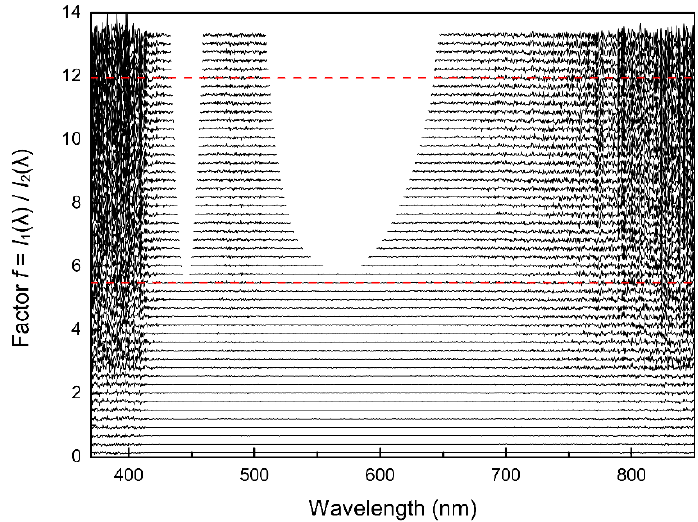
Figure 11. Illustration of the linear dependence of the corrected intensities on the integration time. The ratios f of I 1 ( λ ) to I i ( λ ) are plotted versus the wavelengths (nm) for several integration times. The correction is valid for di ff erent intensities at di ff erent integration times and wavelengths and thus verifies the applicability of the correction function. The dashed red lines are expected characteristics for two arbitrarily chosen integration times, the black lines are the corrected observed characteristics for several integration times (compare also with Figure